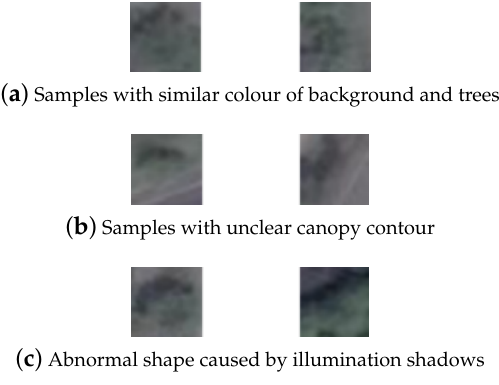
Figure 6. Examples of hard-to-classify